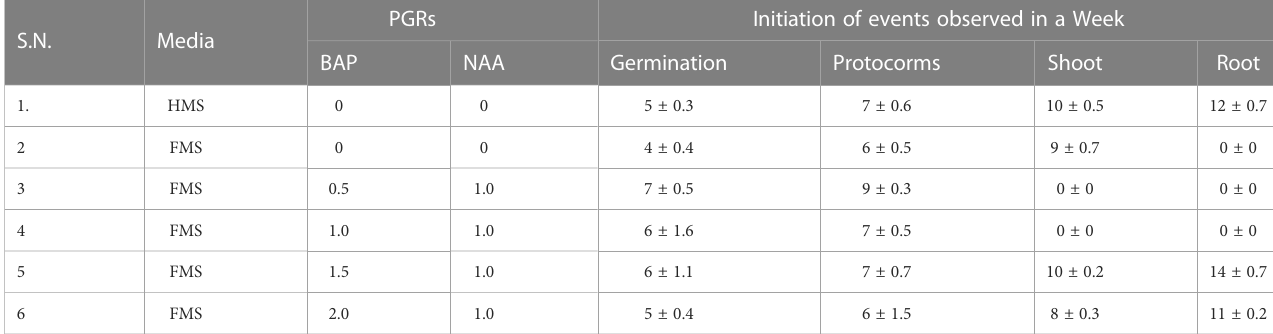
TABLE 1 Effect of different strength of MS medium with/out BAP and NAA for in-vitro culture of D. transparens .